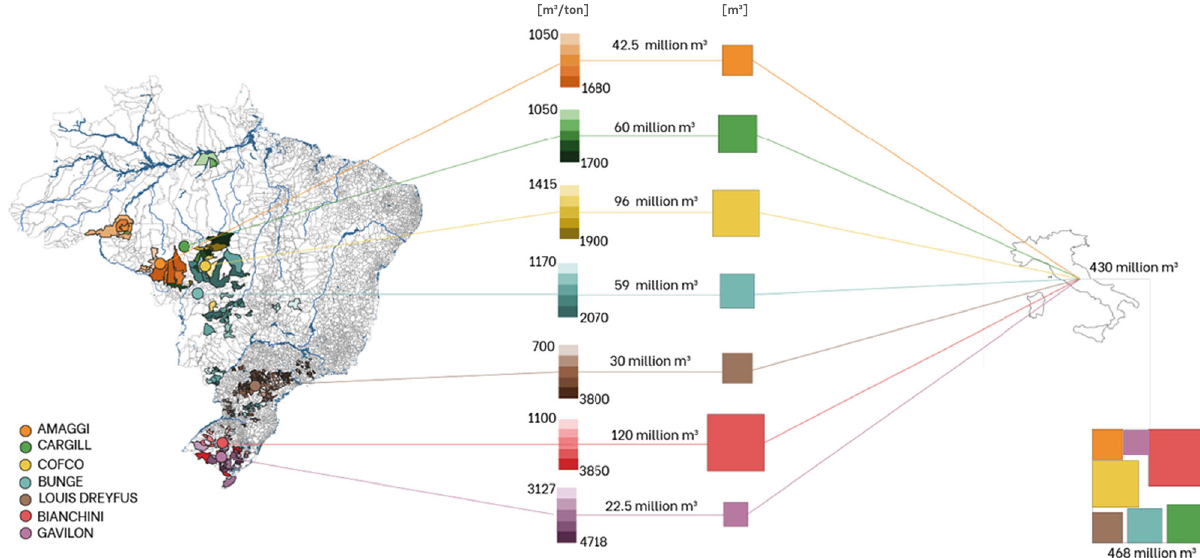
Fig. 3 Tripartite network of the virtual water fl ows (m 3 ) at the company ’ s scale from Brazilian municipalities to Italy in 2018. The map reports the unitary water footprint (uWF) at the company ’ s scale over the Brazilian territory (layer 1). The links depart from the VW weighted barycenters of production of each company and reach their range of uWFs (m 3 /ton) and their total exported volume (m 3 ) (layer 2). A unique colour scale is used for each company, the minimum and maximum values of uWF are shown in the fi rst column and their VW export to Italy in the second column of layer 2. Finally, each VW fl ow is connected to Italy (layer 3). The hierarchies of the companies are aggregated in the treemap, where the empty space accounts for rest of the companies that trade to